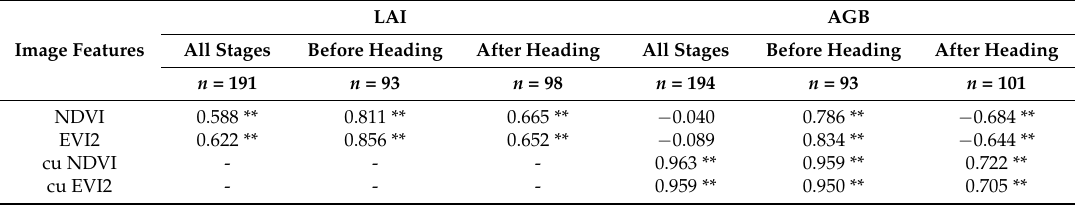
Table 3. Correlation coefficients (r 2 ) between image features and rice growth parameters at different growth